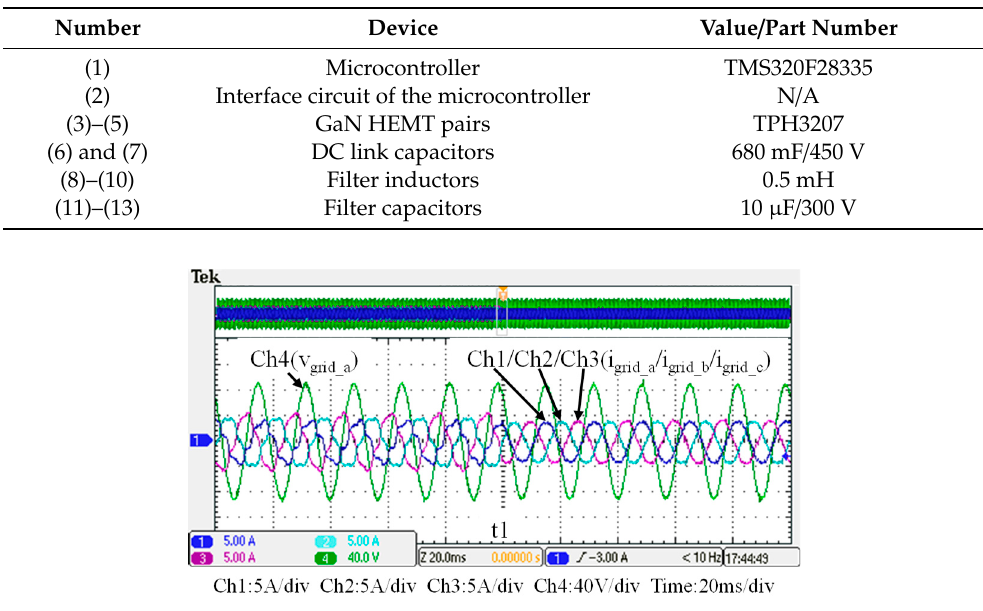
Figure 20. DC link voltage and the shunt APF three-phase currents (t 0 –t 2 ).